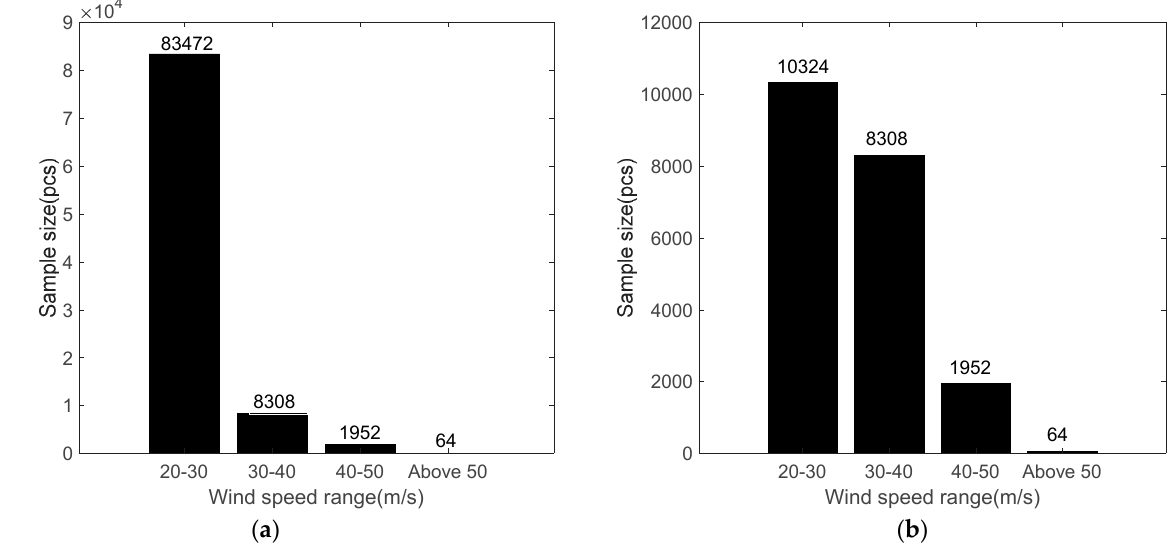
Figure 4. ( a ) Original training samples histogram; ( b ) Final training samples histogram .